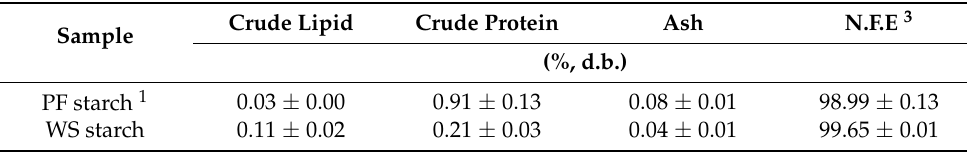
Table 1. Proximate compositions of lotus rhizome starches on dry basis 2